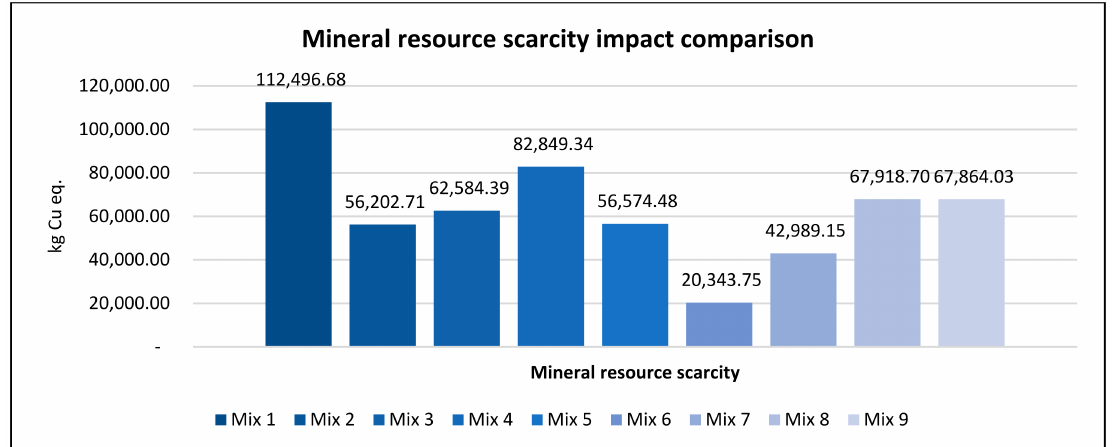
Figure 7. Mineral resource scarcity impact comparison between mineral sealing mix combinations.